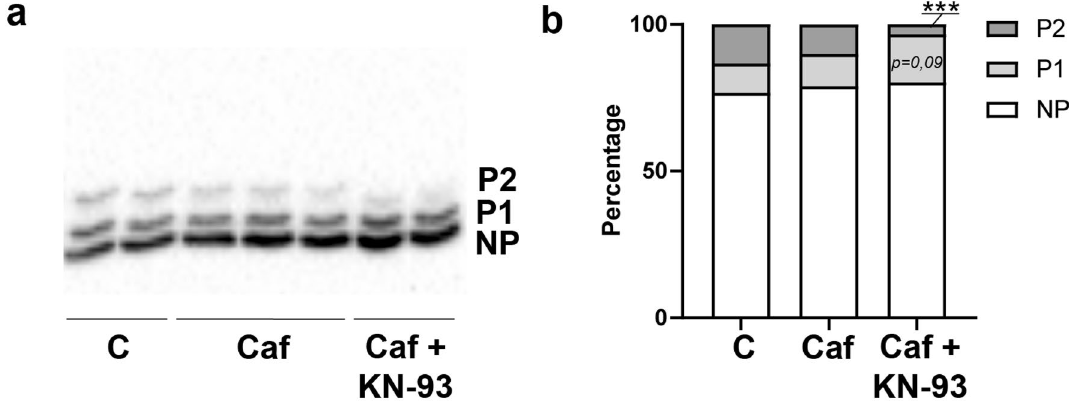
Figure 8. Quantification of the phosphorylated forms of desmin in C2C12 differentiated myotubes consecutively to co-treatment caffeine and KN-93, CamKII activator and inhibitor, respectively. Twenty µg of the whole proteins samples were separated using Phos-tag-PAGE, and desmin was detected using western blot. ( a ) Visualization of phosphorylated pattern of desmin in untreated (C), caffeine (Caf) and caffeine + KN-93 (Caf + KN-93) treated myotubes. The phosphorylated forms of desmin were separated according to the number of phosphate groups (P1: first retarded form of desmin; P2: second retarded form of desmin) comparing with the non-phosphorylated form of desmin (NP). ( b ) The signals were quantified and expressed as the relative percentage of each form (NP, P1 and P2 forms, comparing with the sum of all forms (NP + P1 + P2, equal to 100%, for each condition). ***p < 0.001: significantly different from control (n = 15; N = 3 independent cultures). Uncropped image of blot is presented in Supplemental